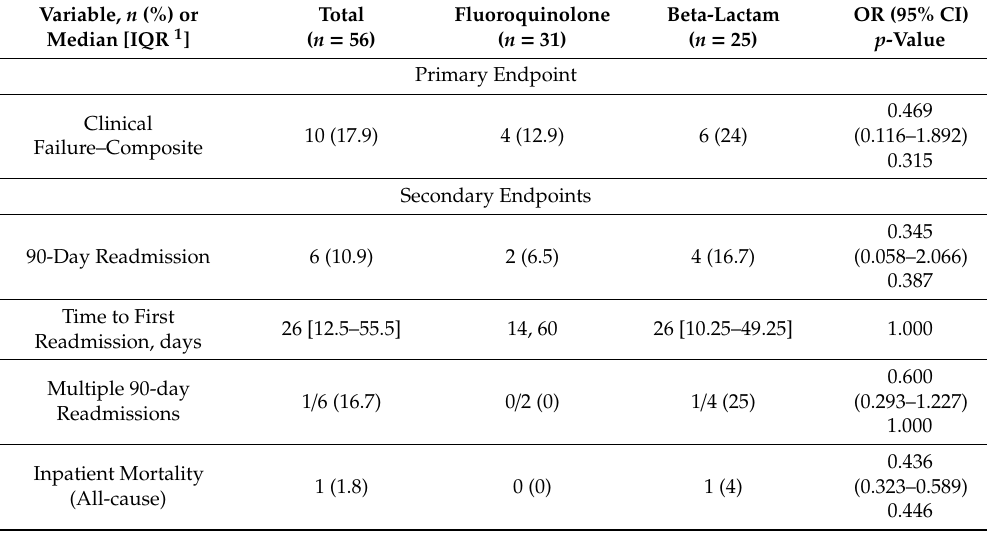
Table 4. Clinical Outcomes of Patients Receiving Fluoroquinolone versus Beta-Lactam Definitive Therapy for CAE Bloodstream